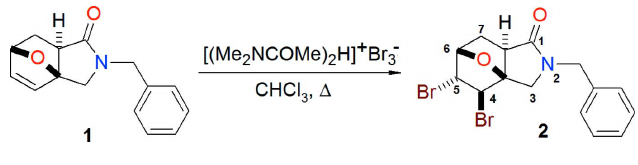
Figure 1 Synthesis scheme